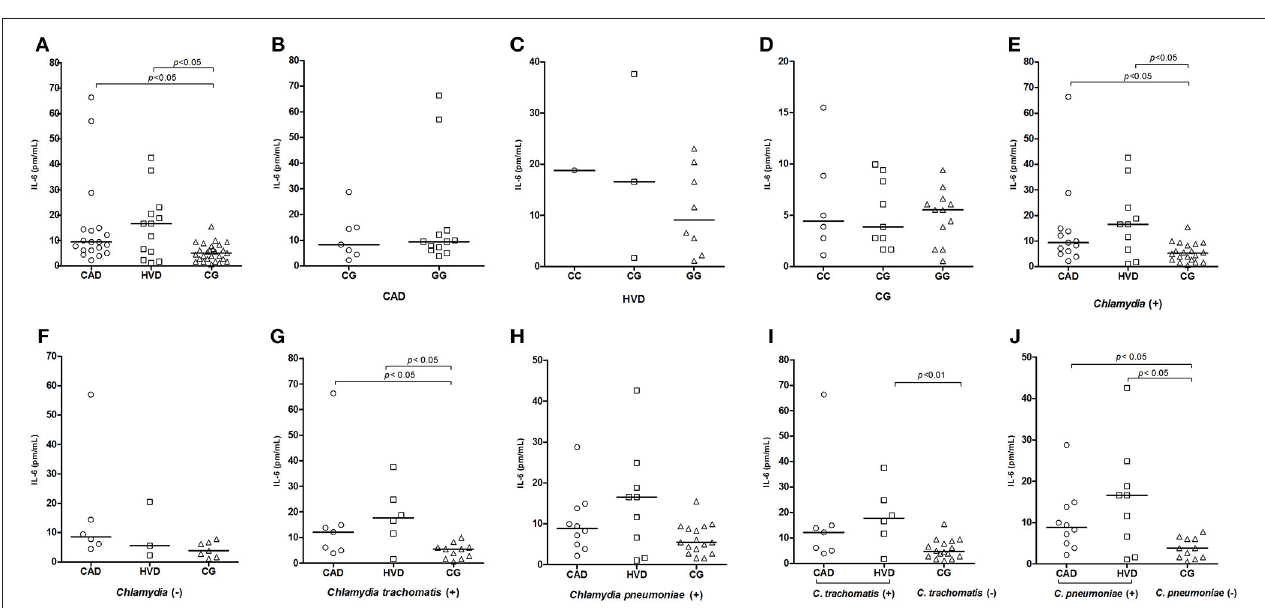
FIGURE 1 | Distribution of plasma C-reactive protein (CRP) levels (A) among patients receiving surgical revascularization for coronary artery disease (CAD), patients undergoing valve replacement for heart valve disease (HVD), and control subjects (CG); (B–D) according to the different CRP- 717T > C genotypes; (E) among groups serologically positive and (F) negative for Chlamydia ; (G,I) among groups with and without previous exposure to C. trachomatis and (H,J) to C. pneumoniae .